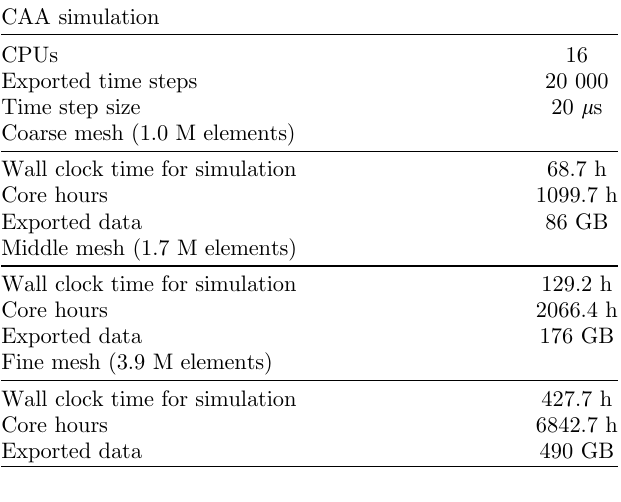
Table 5. CAA simulation statistics.